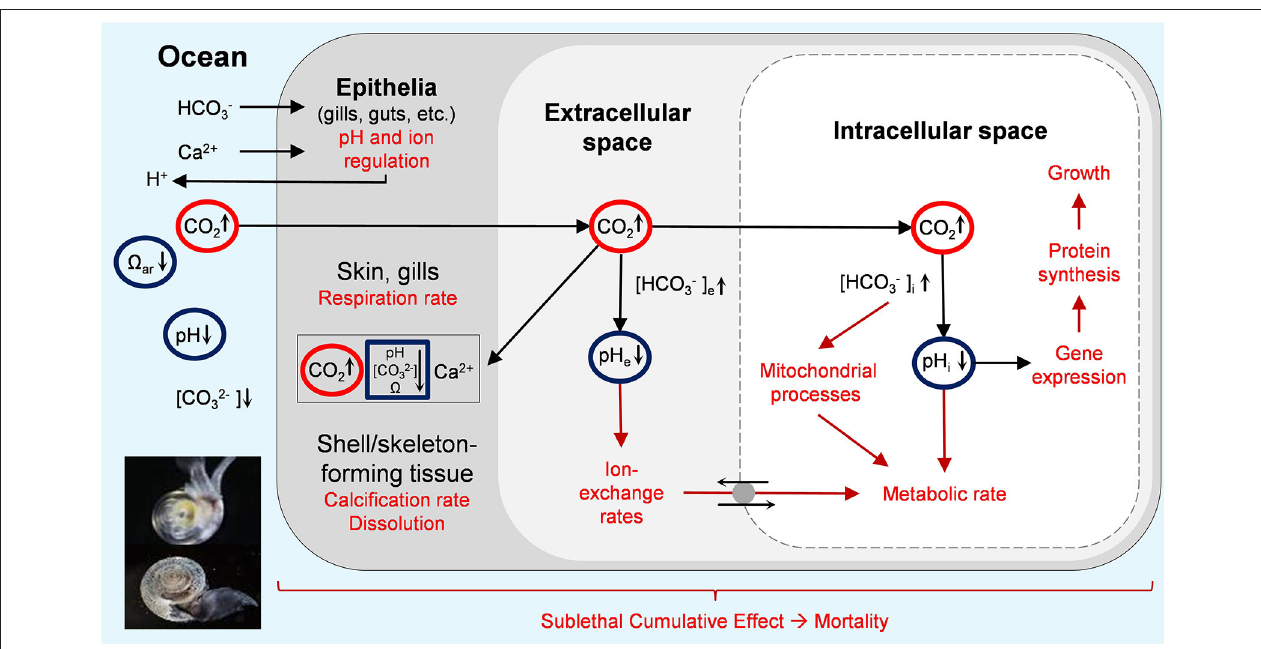
FIGURE 1 | Responses of pteropods to OA. Effects are mediated via diffusive CO 2 entry (black arrows) into body and cell compartments, resulting in a rise in intracellular pCO 2 (highlighted in red), a drop in compartmental pH (highlighted in blue), and their effects (red arrows) on various biological endpoint (red text) in tissues and cellular compartments. In addition, lower aragonite saturation state ( (cid:127) ar ) and carbonate ions (CO 2 − 3 ) has an effect on shell dissolution (depicted as pteropod with intact and damaged shell) and reduced calcification. Figure modified from IPCC